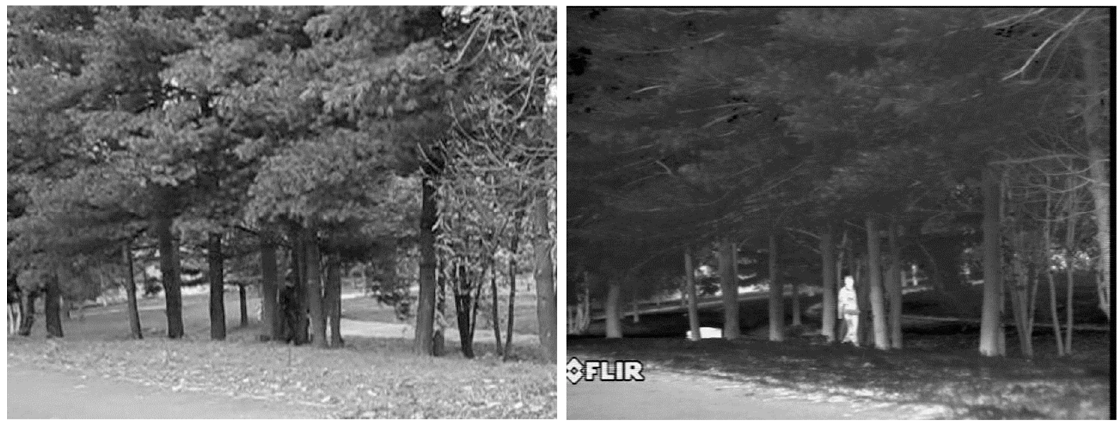
Figure 3. TV and IR sequences of the same scene.